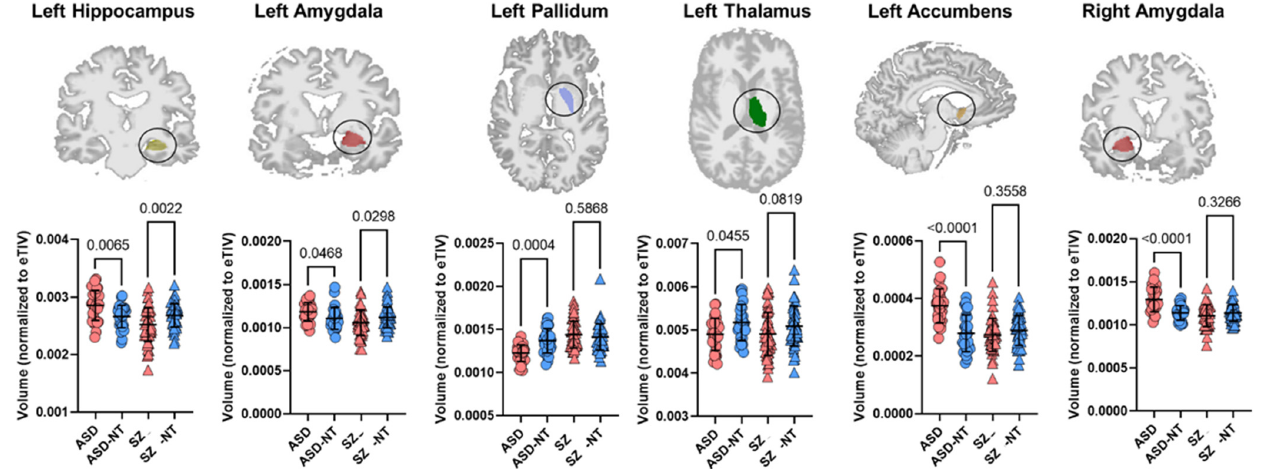
Figure 2. Mean ± standard deviation for eTIV-normalized volumetric measures of subcortical structures in disorder groups and their respective neurotypical groups (ASD [ n = 29] and ASD-NT [ n = 29]; SZ [ n = 51] and SZ-NT [ n = 51]). Statistical significance is indicated numerically. Red circle: ASD, blue circle: ASD-NT, red triangle: SZ, blue triangle: SZ-NT.